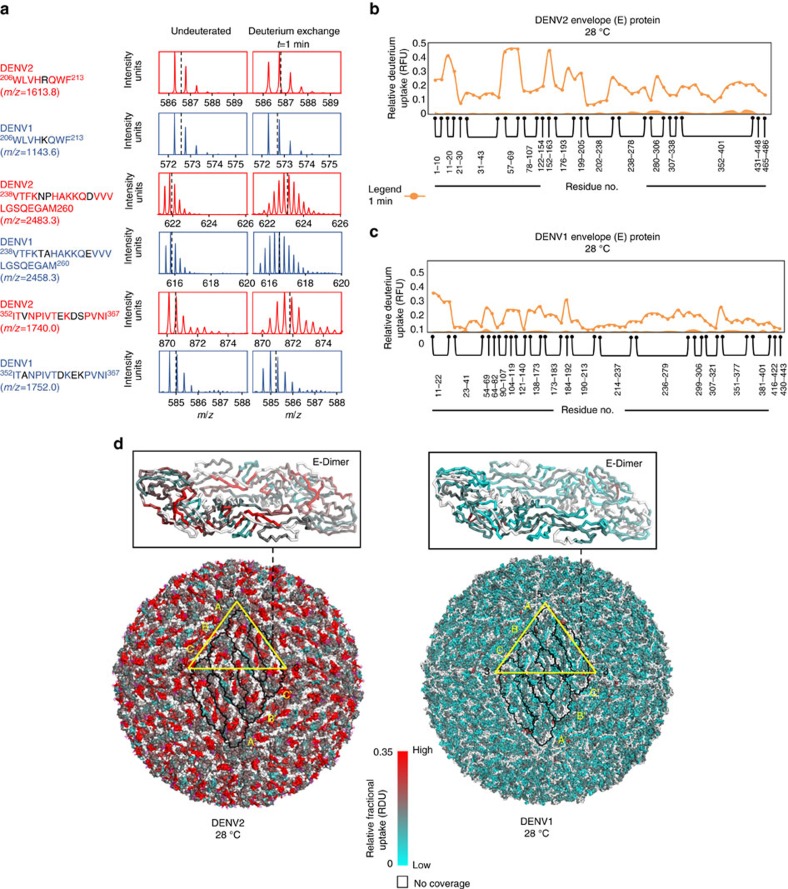
Deuterium exchange of E-protein in unexpanded DENV2 and DENV1 at 28 °C in solution.(a) Representative mass spectra of peptides from E-protein of DENV2 and DENV1 for undeuterated and t=1 min of deuterium exchange at 28 °C. Differences in sequence between DENV2 and DENV1 are indicated in black. Dashed line represents centroid of the mass envelope. Average number of deuterons exchanged in each peptide is determined by subtracting the centroid of the deuterium exchanged peptide from the undeuterated peptide. Relative deuterium exchange (RFU) is the fraction of average deuterons exchanged relative to the maximum number of exchangeable amides in each peptide. (b,c) RFU values for each E-protein pepsin fragmentation peptide listed from the N-to-C-terminus after 1 min of deuterium exchange are shown for DENV2 and DENV1 at 28 °C in a modified mirror plot respectively. Each dot represents one pepsin fragment peptide, Y-axis-Relative fractional uptake of deuterium (RFU), X-axis-pepsin fragment peptides, listed from N to C terminus. (d) RFU after 1 min of deuterium exchange at 28 °C is mapped onto whole viral particles in a colour coded gradient scale on DENV2 (PDB ID: 1OAN) and DENV1 (PDB ID: 4CCT). Regions with no peptide coverage are white. Each E-protein monomer is outlined (consisting of 6 monomers). E-protein units adjacent to the five-fold, two-fold and three-fold vertices are labelled A, B and C respectively. Insets: RFU after 1 min of deuterium exchange at 28 °C mapped onto a unit of E-protein dimer from DENV2 and DENV1. S.e. for each peptide is shown as shaded regions along the X-axis. The s.e. for a given peptide represents a single sigma s.d.. of all (minimum three) the independent HDXMS measurements.